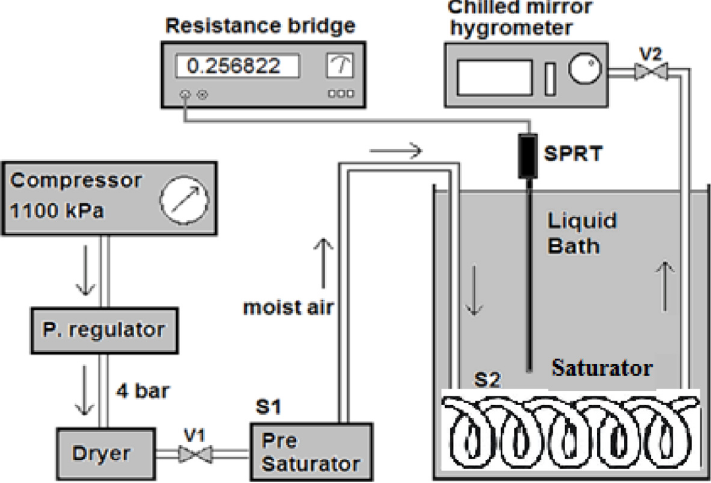
Fig. 2. Schematic diagram of one temperature generator.